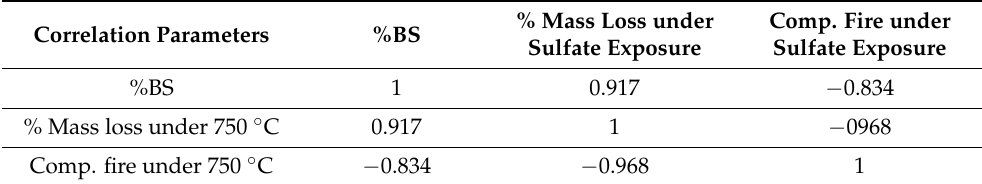
Table 5. The correlation coefficient between %BS, compressive strength, % mass loss with sulfate exposure at 365 days for group Z.